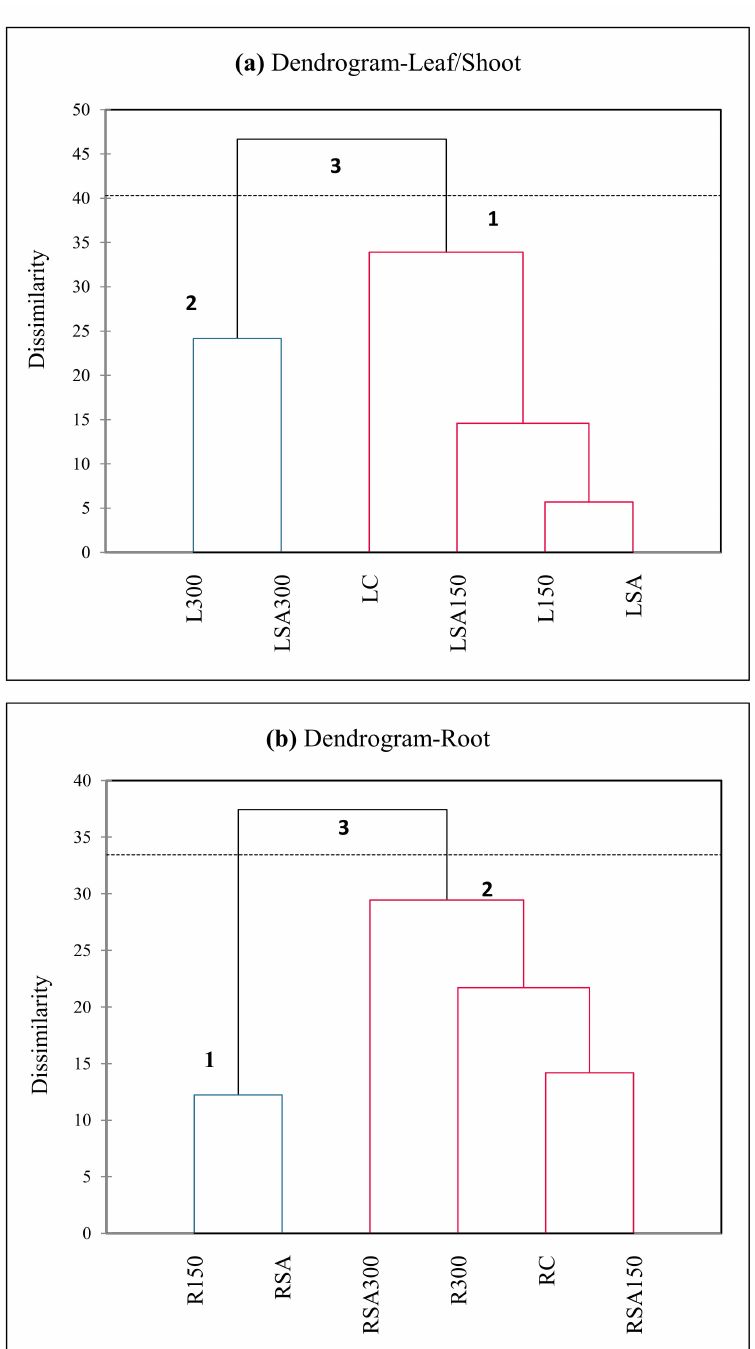
Figure 7. The clustering dendrograms representing dissimilarity between endogenous hormones and basic morphological and physiological parameters in leaves ( a ) and roots ( b ) in the bar- ley seedlings under salt and exogenous SA treatments, obtained by the UPGMA clustering method with Euclidean distance, considering the concentration attained by the UPGMA clus- tering. LC; leaf control, L150; leaf 150 mM NaCl, L300; leaf 300 mM NaCl, LSA; leaf 0.5 mM SA, LSA150; leaf 150 mM NaCl + 0.5 mM SA, LSA300; leaf 300 mM NaCl + 0.5 mM SA, RC; root control, R150; root 150 mM NaCl, R300; root 300 mM NaCl, RSA; root 0.5 mM SA, RSA150; root 150 mM NaCl + 0.5 mM SA, RSA300; root 300 mM NaCl + 0.5 mM